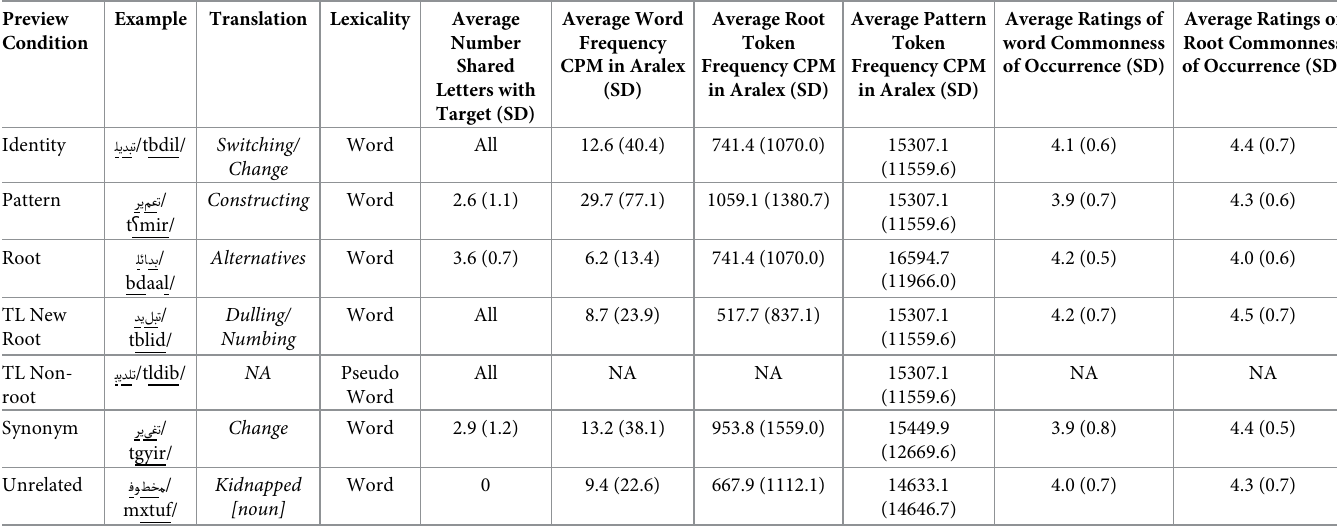
Table 1. Preview conditions details and an example.